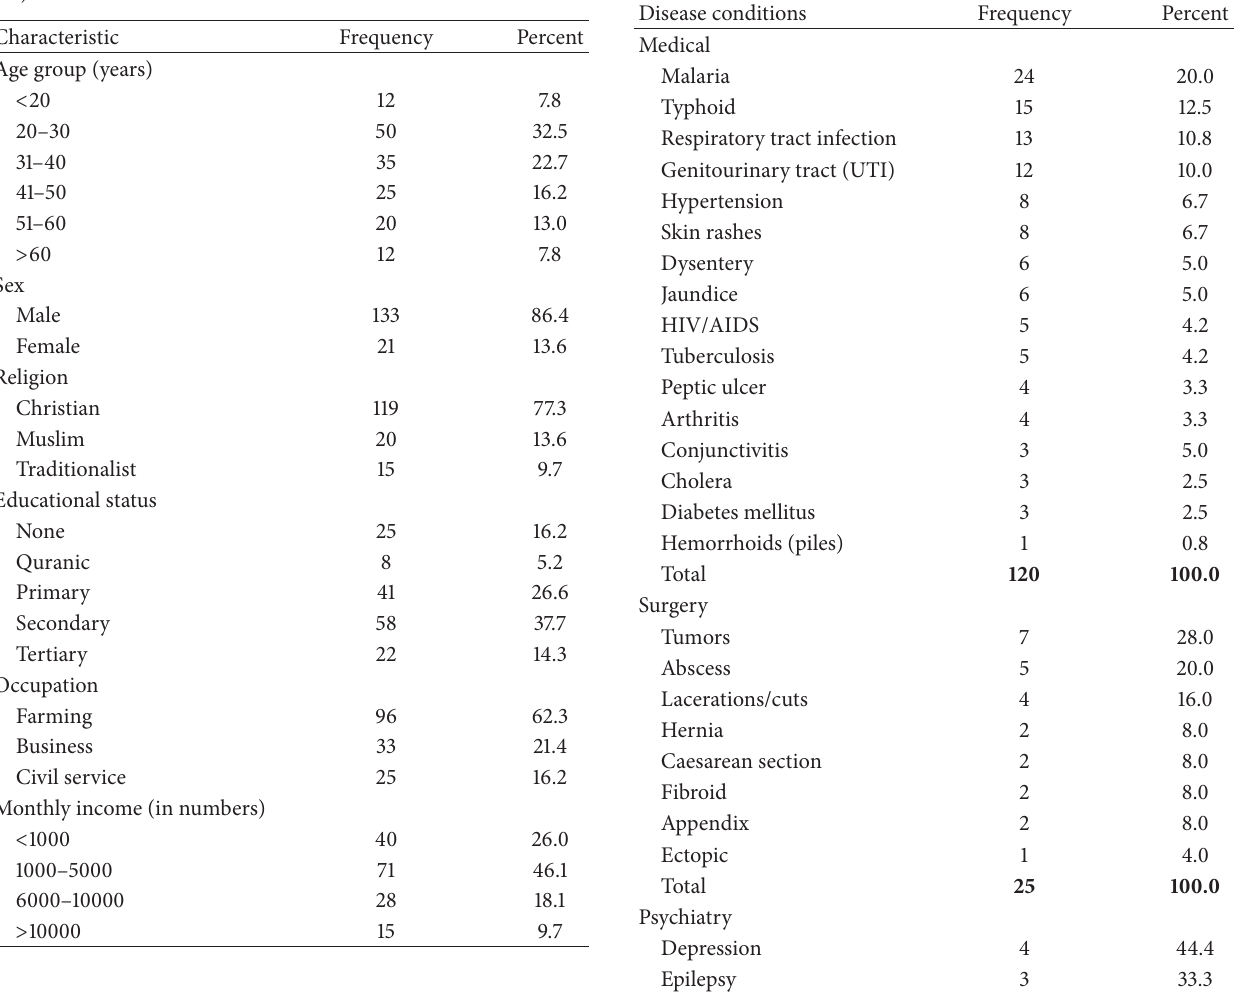
Table 2: Respondents’ major causes of